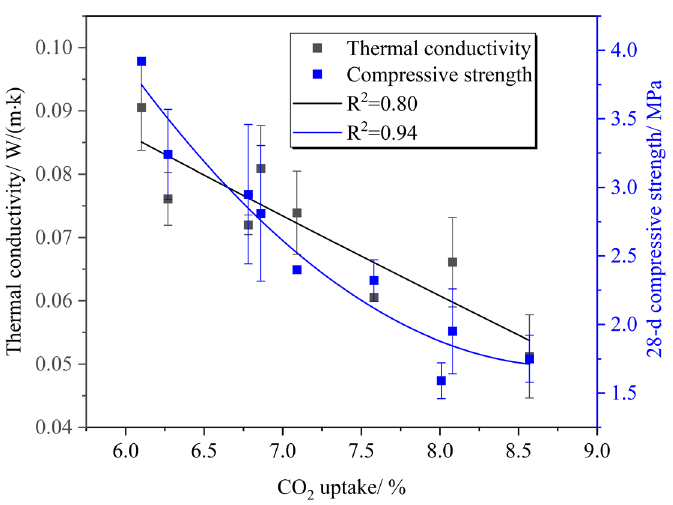
Figure 9. Relationship between the thermal conductivity and 28 d compressive strength and CO 2 uptake.